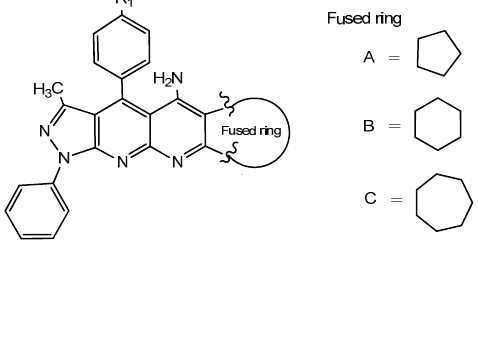
Table 3. Minimum inhibitory concentrations (MIC 100 , MIC 80 and MIC 50 ) and minimum fungicidal concentrations (MFC) of 3a – i grouped by their structural features against standardized strains of Candida albicans and C. neoformans